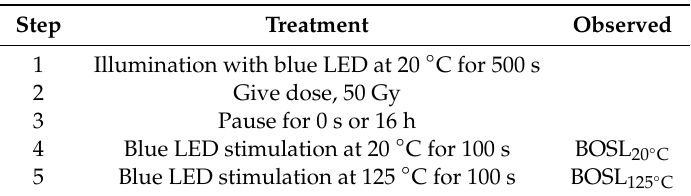
Table 3. Sequence of procedures used to measure OSL sensitivity of pure quartz aliquots without preheating and with light stimulation at room temperature (20 ◦ C). BOSL 20 ◦ C and BOSL 125 ◦ C represent the signals used for sensitivity calculation.